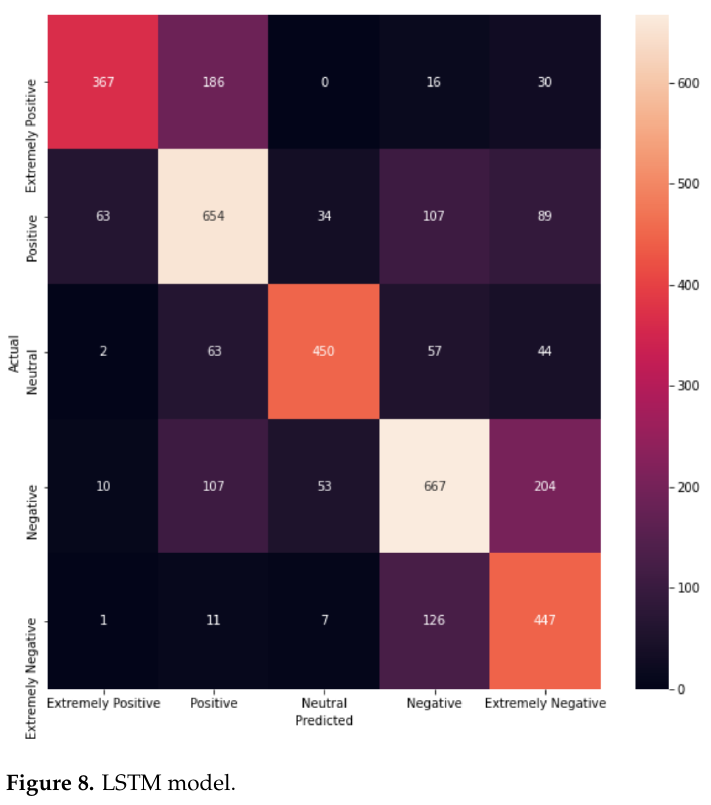
Figure 8. LSTM model.